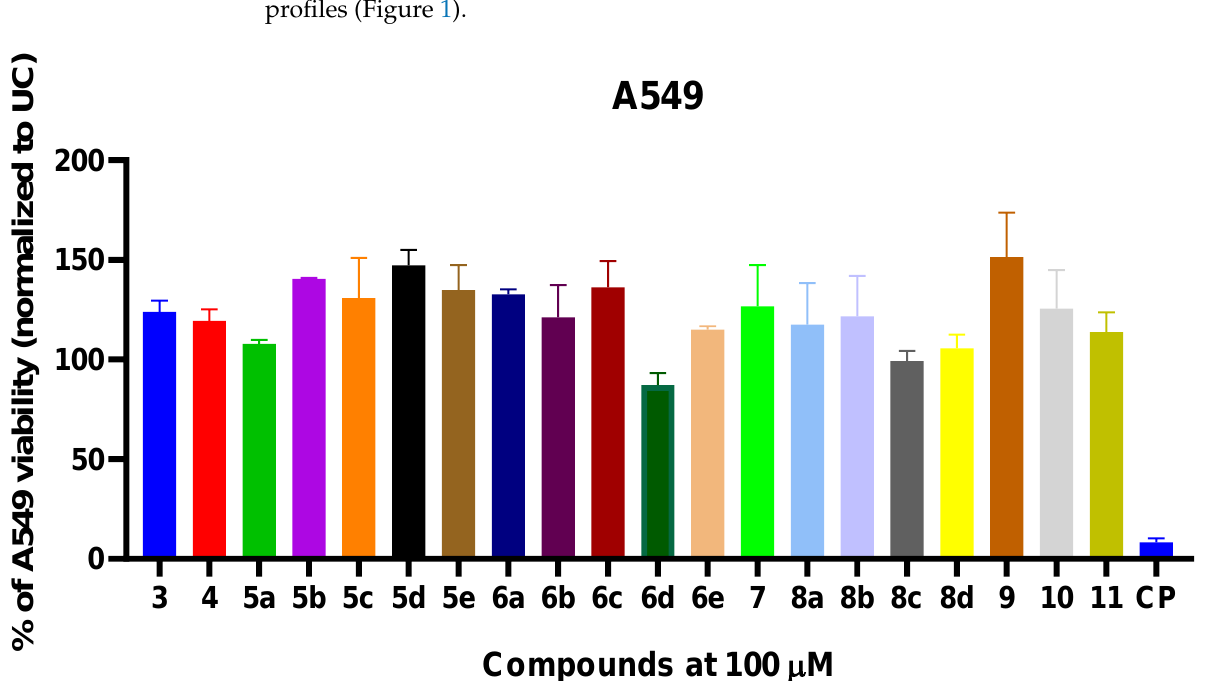
Figure 1. The in vitro cytotoxicity of compounds 3 – 11 on A549 human pulmonary cells. The A549 cells were treated with 100 µ M of each compound or cisplatin (CP) that served as control for 48 h, and the post-treatment viability was measured by using MTT assay. The viability of untreated control (UC) was used for the post-treatment-viability normalization. Data are shown as mean ± SD from three experimental replicates.